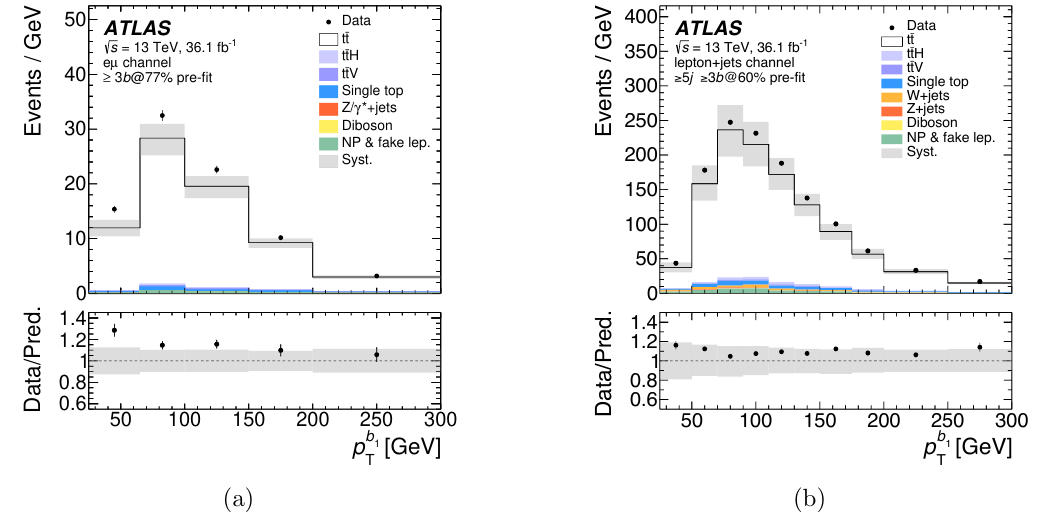
Figure 3. Comparison of the data distributions with predictions for the leading b -tagged jet p T , in events with at least 3 b -tagged jets, in the (a) e(cid:22) and (b) lepton + jets channels. The systematic uncertainty band, shown in grey, includes all uncertainties from experimental sources. Events that fall outside of the range of the x -axis are not included in the plot.